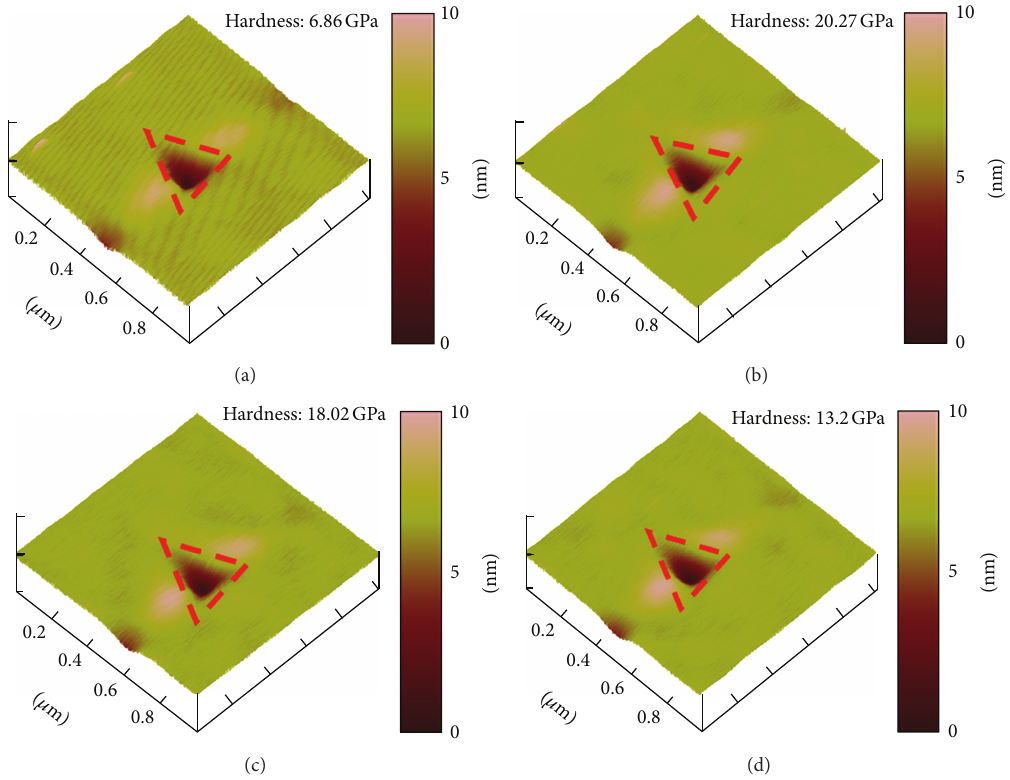
Figure 4: AFM topography after the nanoindentation test for the D263T glass substrates coated with and without DLC films prepared under a large load of 500 𝜇 N: (a) D263T glass substrates, (b) specimen GD 9, (c) specimen GD 6, and (d) specimen GD 3.